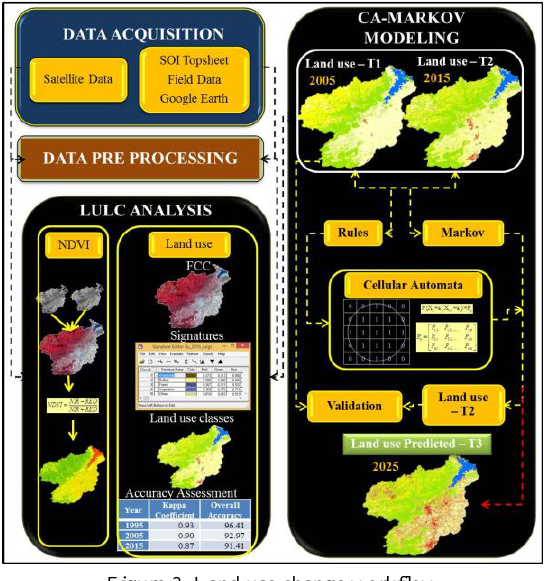
Figure 3. Land use change